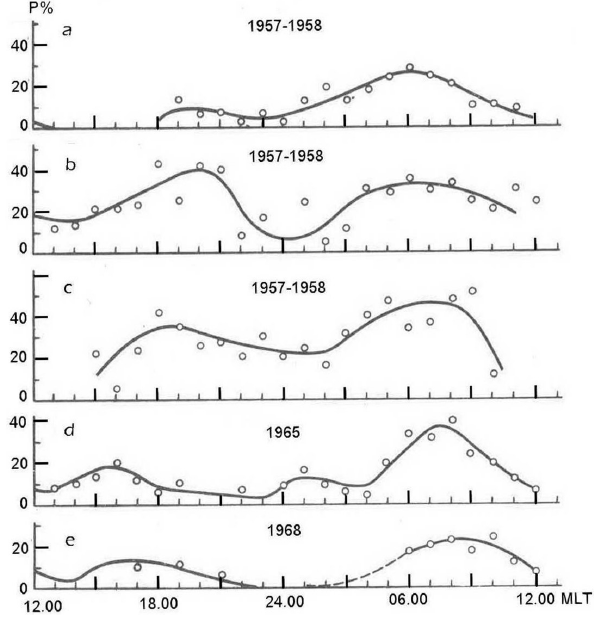
Figure 10. Diurnal variation of the PCA appearance frequency for the stations Thule (a) , Alert (b) , and Resolute Bay (c) in the North- ern Hemisphere and the station Vostok (d, e) in the Southern Hemi- sphere (after Yahnin and Sergeev, 1981).